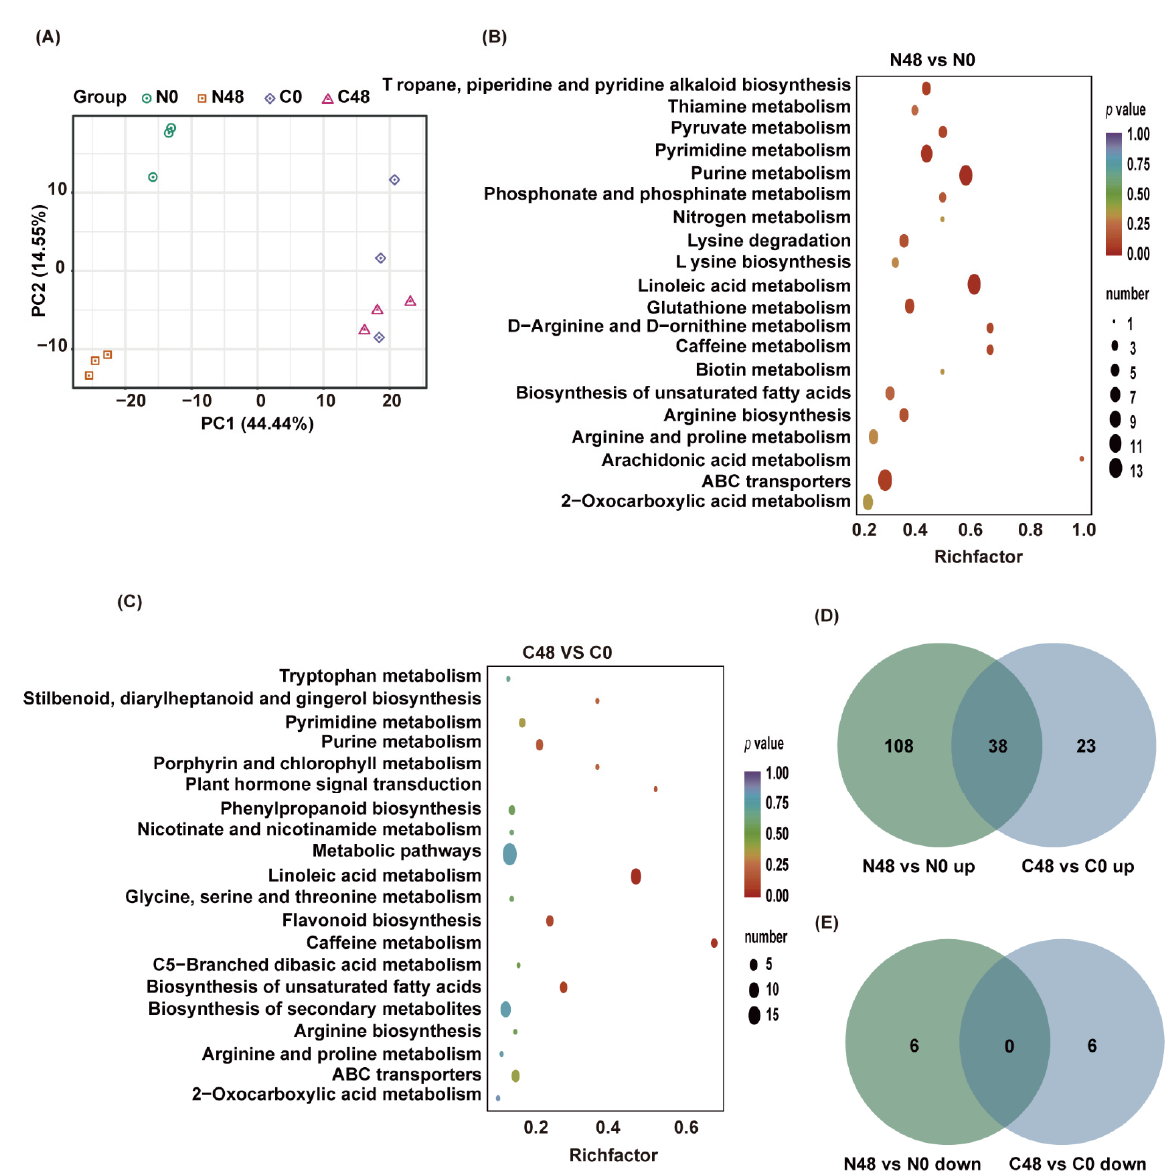
Figure 2. Different accumulated metabolites (DAMs) of Nipponbare and C331 fed by BPH for 48 h. ( A ) PCA plots of metabolism identified by LC-MS/MS of Nipponbare and C331 attacked by BPH at 0 and 48 h post-infestation. ( B ) Enrichment scatter diagram of the top 20 KEGG pathways of DAMs in Nipponbare exposed to BPH stress for 48 h. ( C ) Enrichment scatter diagram of the top 20 KEGG pathways of DAMs in C331 exposed to BPH stress for 48 h. ( D ) Venn diagram of upregulated DAMs in C331 and Nipponbare. ( E ) Venn diagram of downregulated DAMs in C331 and Nipponbare.